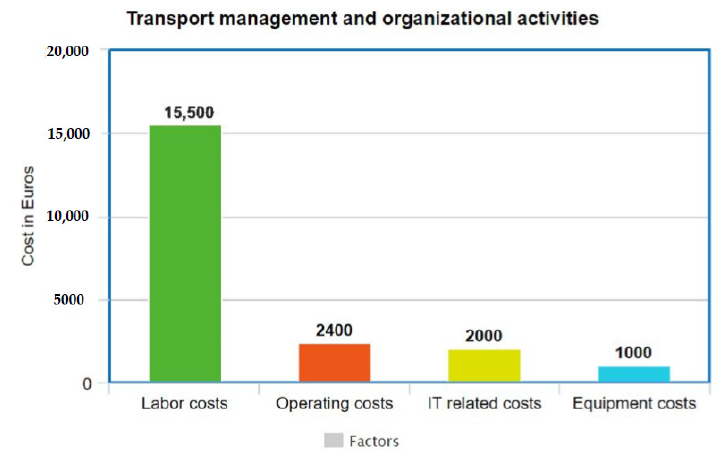
Figure 2. Factors affecting transport management cost.